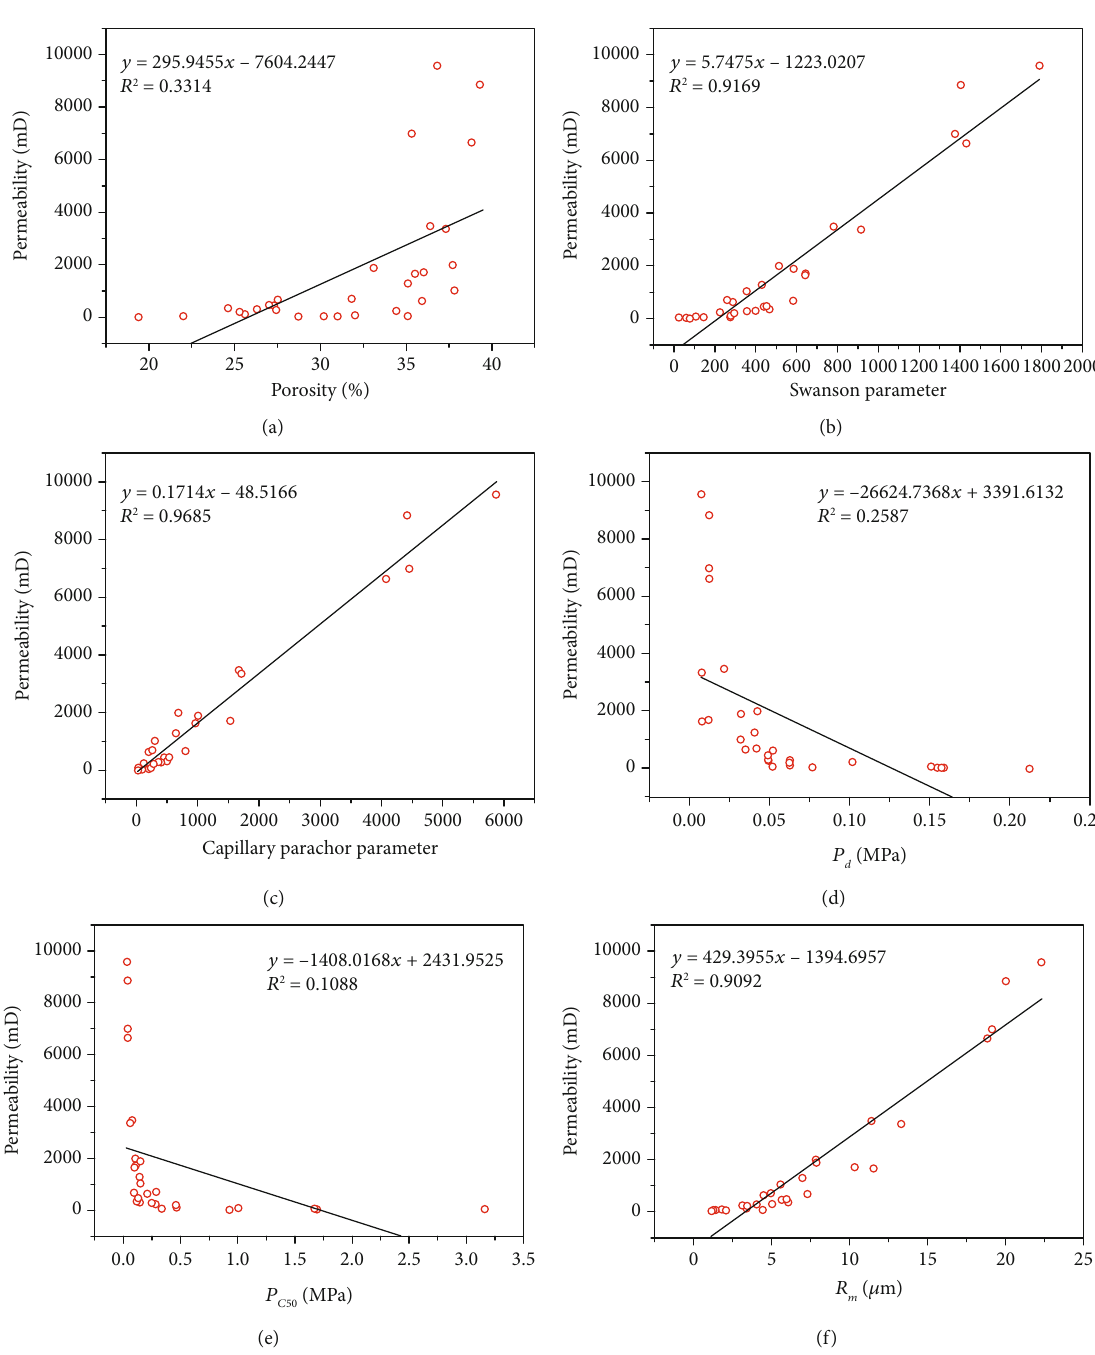
permeability, (e) P permeability, and (f) Rm d C 50